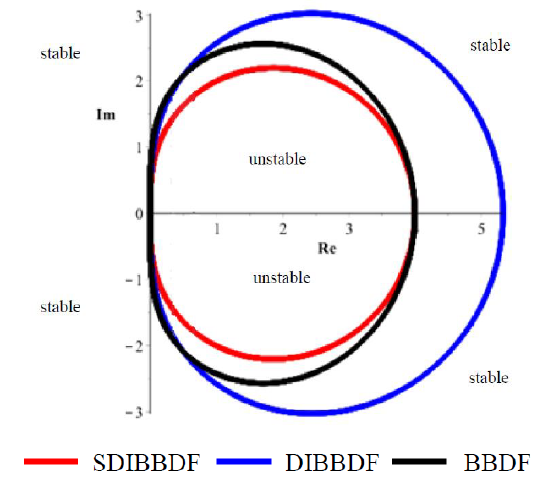
Figure 4. Comparison of stability graph between SDIBBDF, BBDF and DIBBDF